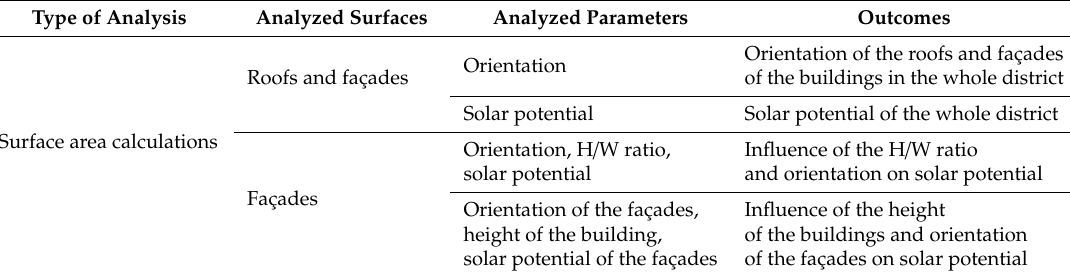
Table 5. Type of analysis included in the data